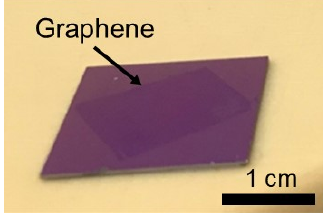
Figure 1. Optical image of graphene on a silicon substrate.